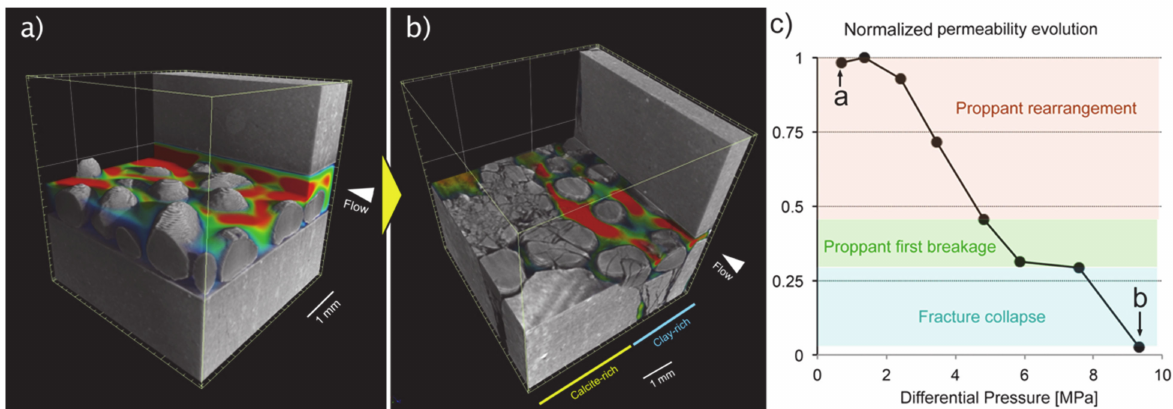
Figure 13. In situ SXRmCT forced closure of propped fracture by increasing the differential stress of the system: a shale sample with a single fracture filled with quartz proppant is measured in a mini-triaxial cell while increasing the stress perpendicular to the fracture plane, in increments. From the tomographic datasets (rendered in gray) Stokes flow simulations are run to calculate the velocity flow fields (rendered in colors) and the fracture conductivity at the different stages (( a ): starting point, ( b ): maximum applied stress). Coupling imaging and modeling allows to understand the role of the different mechanisms involved in the loss of conductivity during the closure process ( c